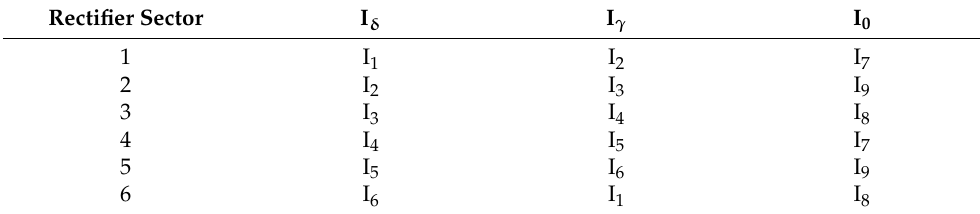
Table 1. The layout of the rectifier vectors according to the sector.